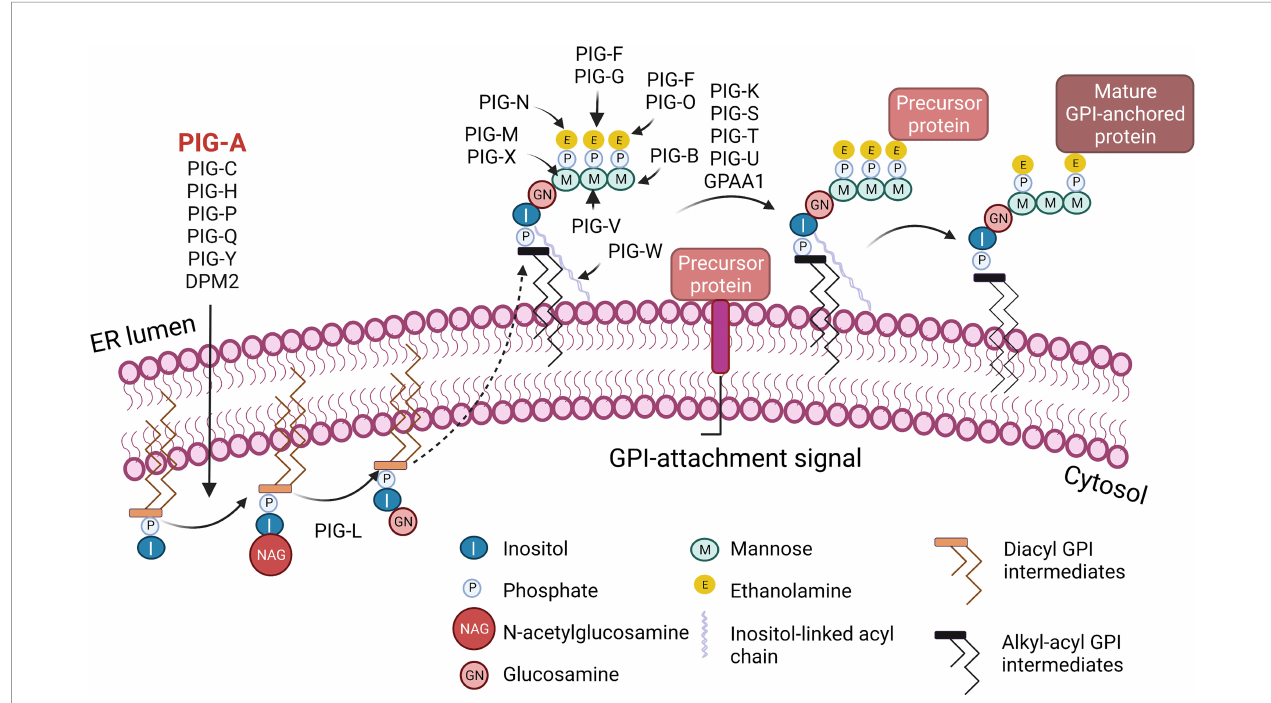
FIGURE 1 | Biosynthesis of glycosylphosphatidylinositol (GPI)-anchored proteins. GPI-anchored proteins are surface proteins linked to the membrane through a GPI glycolipid attachment. GPI is synthesized through a series of steps on the membrane of the endoplasmic reticulum (ER). The initial step involves the transfer of N- acetylglucosamine to inositol on the cytoplasmic side of the ER membrane by a multi-subunit enzyme comprised of seven proteins that include PIGA . A series of subsequent steps, most of which occur on the luminal side of the ER membrane, produce the mature GPI moiety, which is then transferred to the C-terminus of the precursor protein that contains a GPI-anchor attachment signal. Following attachment of GPI, the GPI can be further modi fi ed and remodeled during its transport through the Golgi network on the way to the cell surface. I, Inositol; M, Mannose; P, Phosphate; E, Ethanolamine; NAG, N-acetylglucosamine; GN, Glucosamine. Figure created with